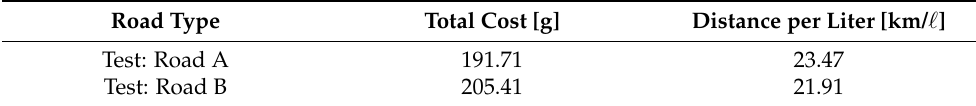
Figure 10. Simulation results of the proposed method at N iter = 1 and N iter = 600 for the test data on Road A (engine torque, engine speed, SoC , and total cost). Table 5. The total cost of proposed method without the traffic congestion vector at